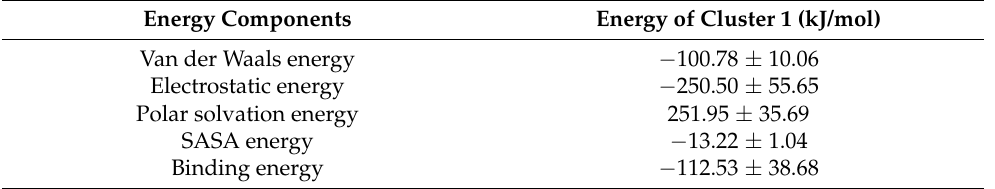
Table 4. Energy components of the MGAM ‐ WA complex.